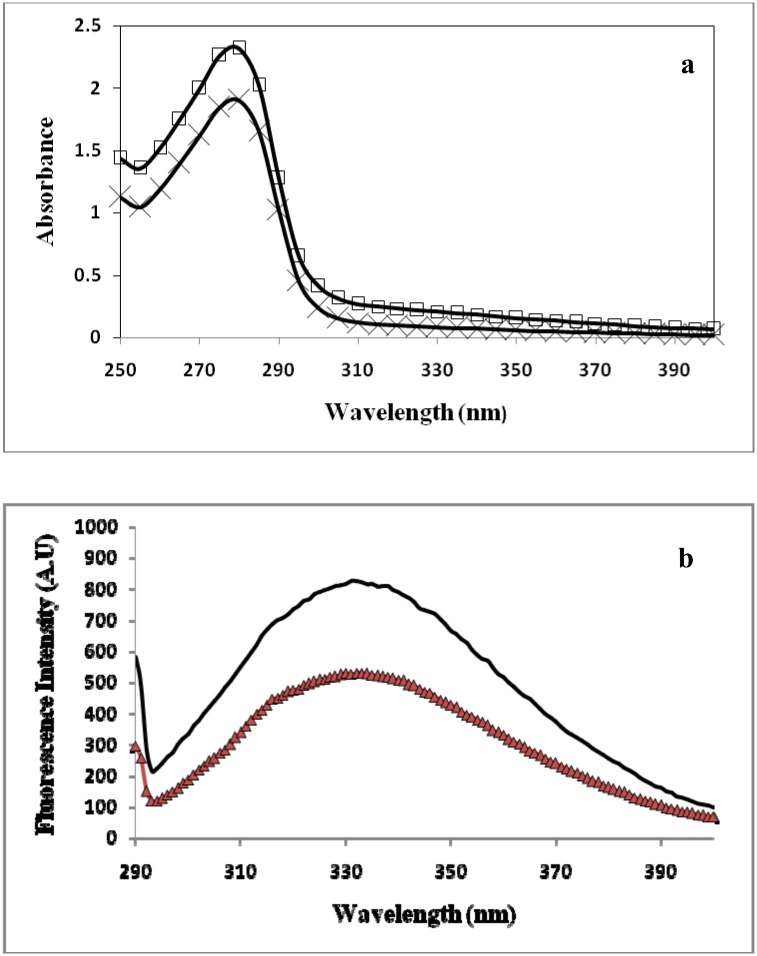
(a) Ultraviolet absorption spectra of native HSA+IgG immune complex and AGEs HSA+IgG immune complex with 400 mg/dL D-glucose.Fluorescence emission profile of immune complex (native HSA+IgG) shown by black colour and immune complex (AGE-HSA+IgG) shown by red colour.